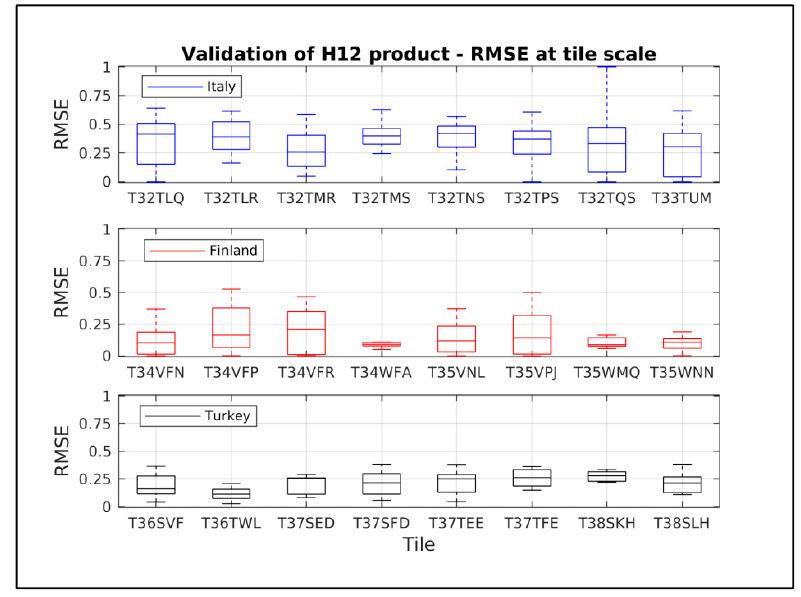
Figure 17. RMSE at tile scale in Italy, Finland, and Turkey.